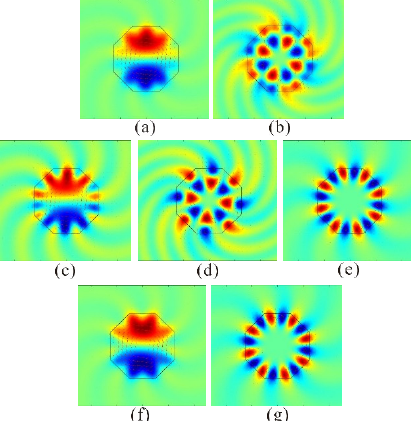
Figure 6. X-components (E x ) of electric field distributions of a guided mode TE 01 and leaky modes EH 32+ and EH 71+ in a twisted octagon-shaped core fiber with R = 25 μm, NA = 0.065, λ = 1064 nm, and Λ = 4.2 mm (( a ) TE 01 , ( b ) EH 32+ ), 4.4 mm (( c ) TE 01 , ( d ) EH 32+ , ( e ) EH 71+ ), 4.6 mm (( f ) TE 01 , ( g ) EH 71+ ).